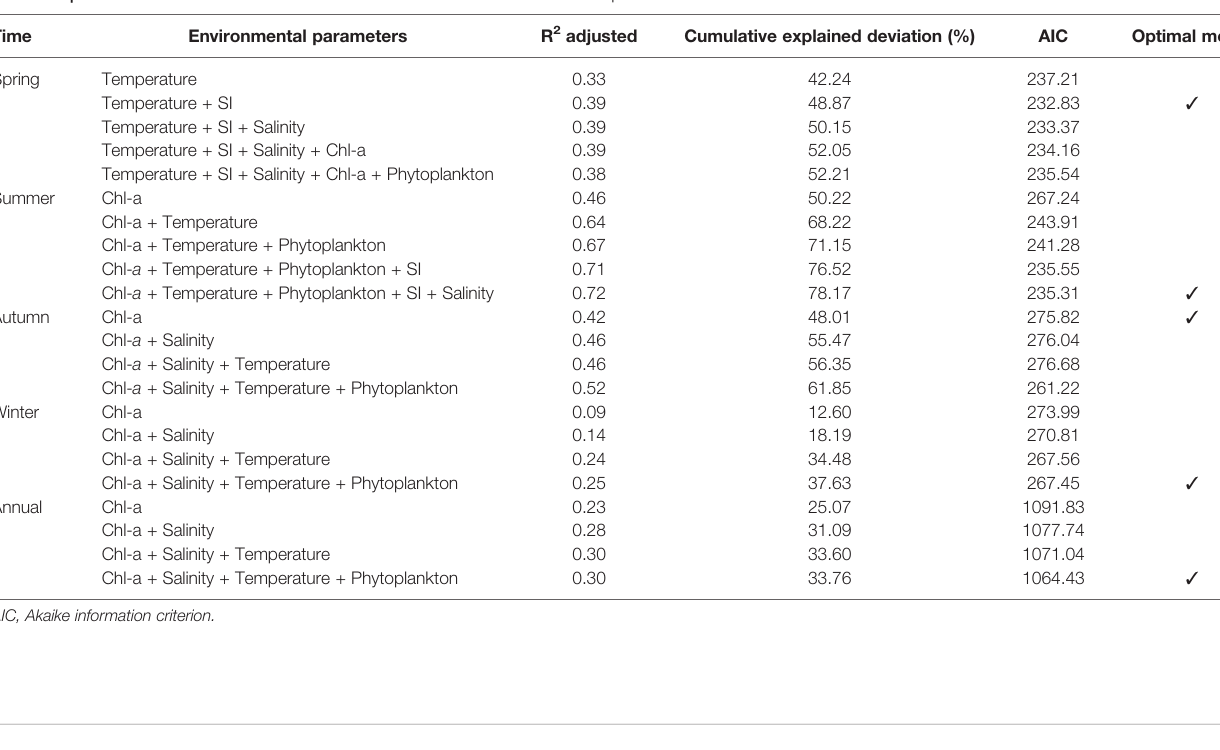
TABLE 4 | Results of GAMs between N. scintillans abundance and environmental parameters.